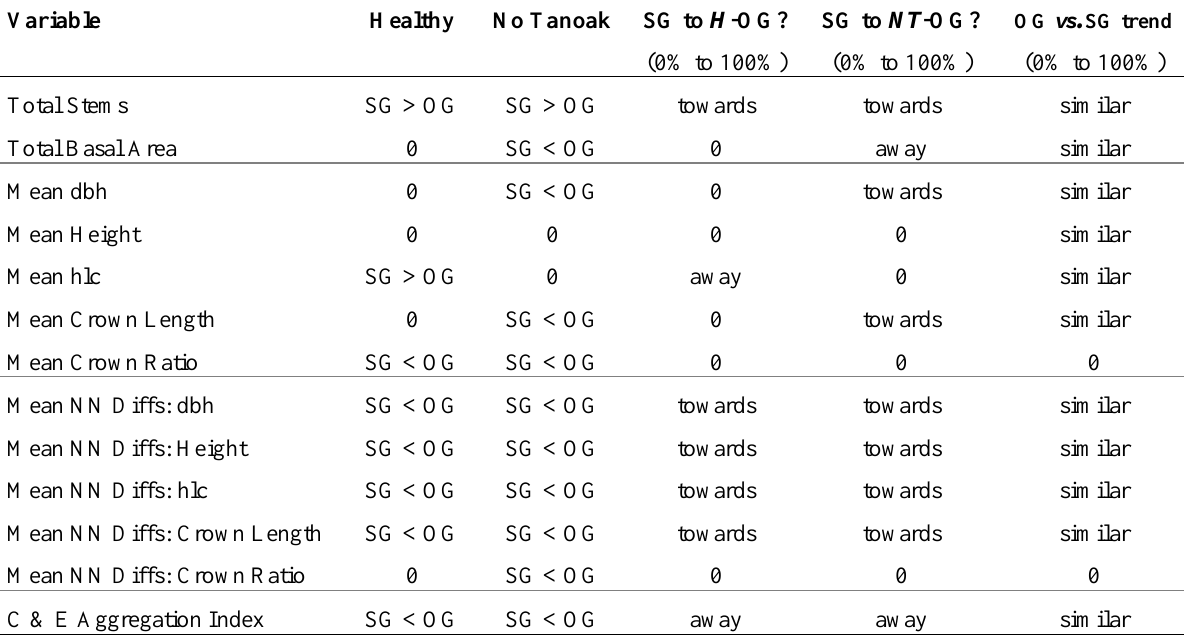
Table 3. Anecdotal relationships between second-growth and old-growth. In the “Healthy” and “No Tanoak” columns, relationships are displayed for metrics in which all second-growth plot values (within the specified sampling strata) were consistently higher or consistently lower than the old-growth plot. In the “SG to H -OG?” column, “towards” indicates that the removal of tanoak was predicted to shift values of the given metric (for second-growth plots) towards the value of the healthy old-growth plot, while “away” indicates a predicted shift in the opposite direction of the healthy old-growth value. In the “SG to NT -OG?” column, “towards” indicates that the removal of tanoak was predicted to shift values of the given metric (for second-growth plots) towards the value of the no-tanoak old-growth plot, while “away” indicates a predicted shift in the opposite direction of the “no-tanoak” old-growth value. In the “OG vs . SG trend” column, “similar” indicates that the removal of tanoak from the healthy old-growth plot was predicted to have qualitatively identical impacts ( i.e. , same direction of change) as the removal of tanoak from second-growth plots. Zeros indicate no clear pattern between second-growth and